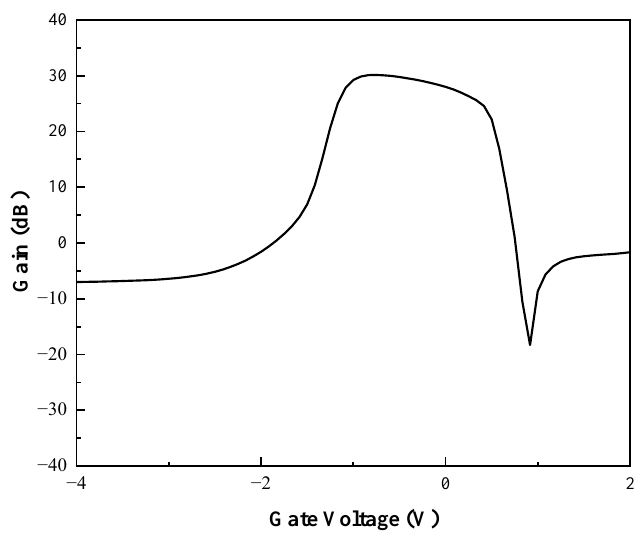
Figure 10. Behavior of G m vs V gs .